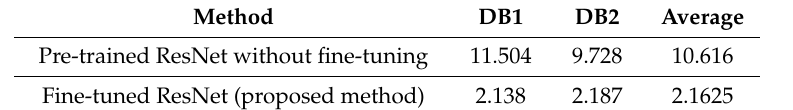
Table 6. Comparative EERs with pre-trained ResNet without fine-tuning and fine-tuned ResNet (unit: %).